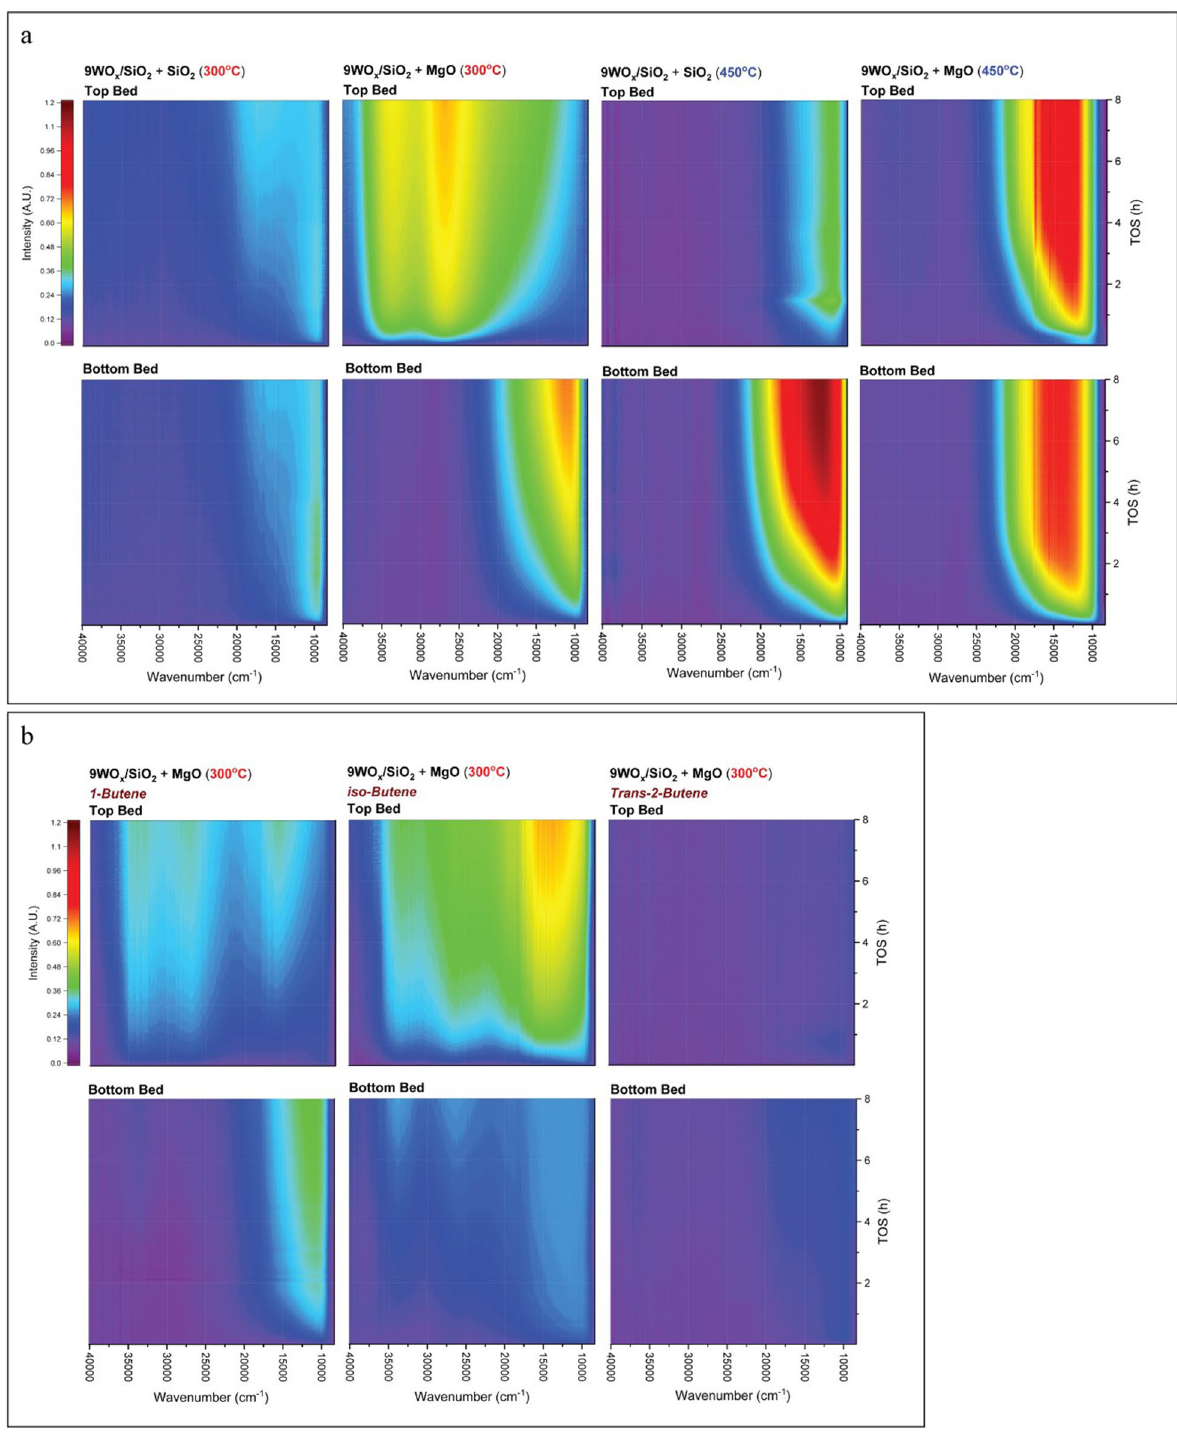
Figure 3. Operando UV–vis spectroscopy with multi probes. The Operando spectrum results of top and bottom of catalytic packed bed. ( a ) The 9WO x /SiO 2 + SiO 2 and 9WO x /SiO 2 + MgO with different reaction temperature at 300 and 450 °C. ( b ) The spectrum results of reaction testing with various reactant as 1-butene, iso-butene, and trans -2-butene which 4% of alkene balanced in N 2